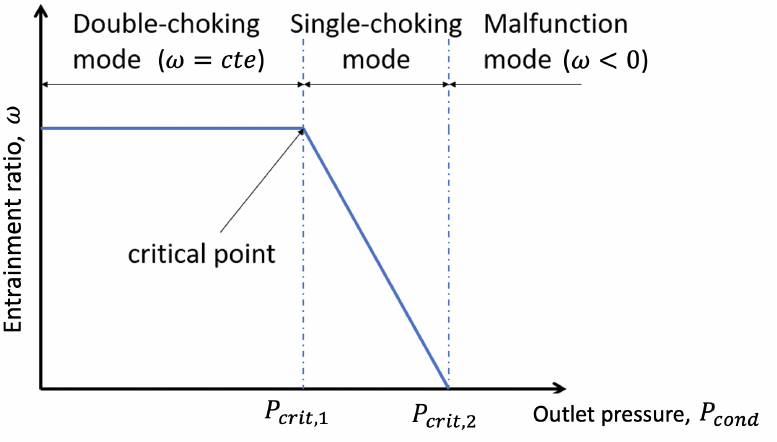
Figure 2. Operating modes of a supersonic ejector for a fixed geometry and given inlet